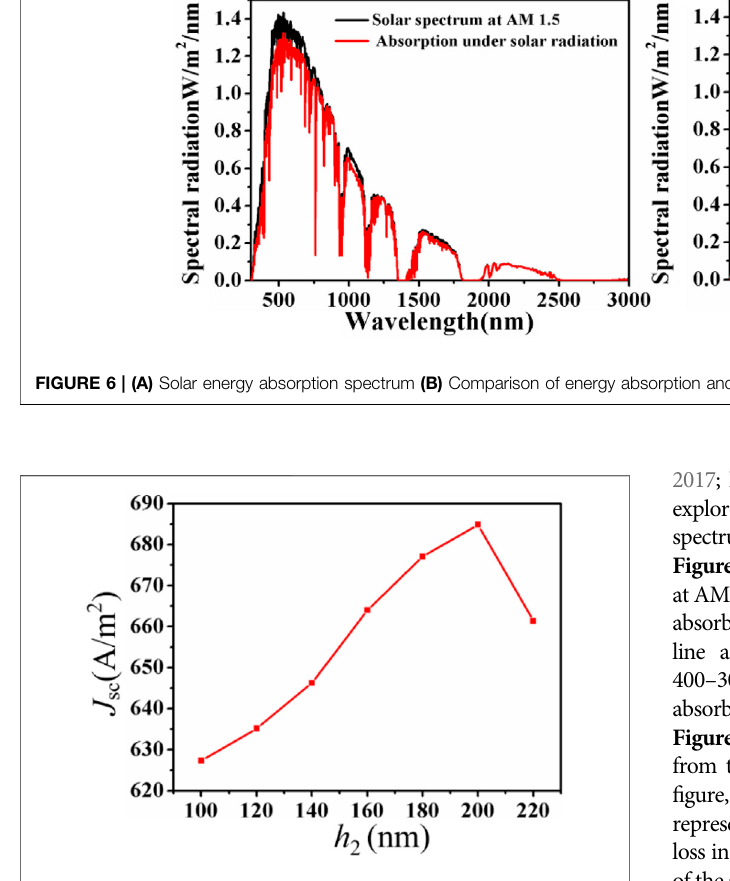
Frontiers in Materials |